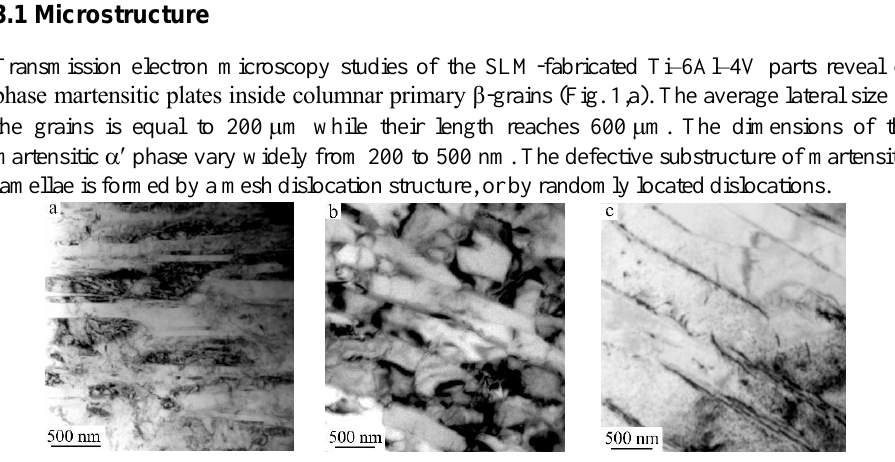
Fig. 1. TEM bright-field images of the microstructures of the SLM-(a), EBM-(b) and EBF 3 -produced Ti–6Al–4V